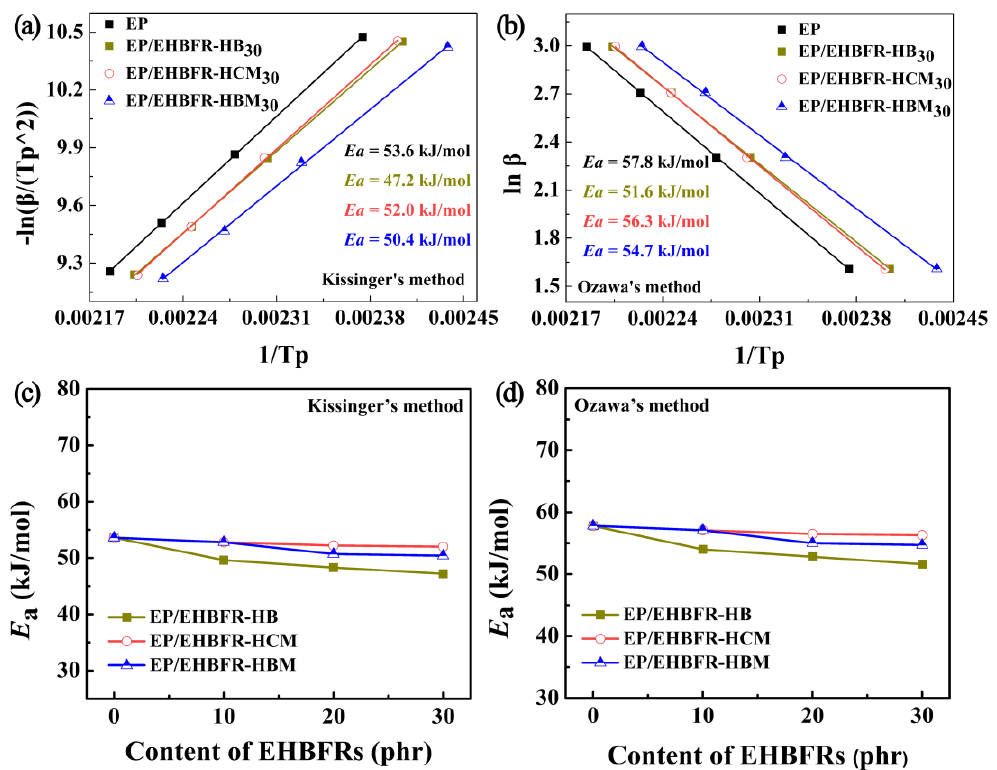
Figure 2. Plots generated following the Kissinger’s ( a , c ) and Ozawa’s ( b , d ) methods for determina- tion of the activation energy of epoxy thermosets. of the activation energy of epoxy